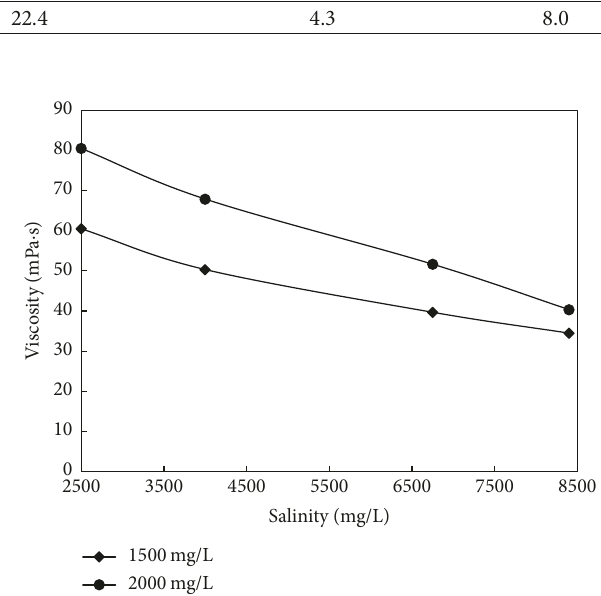
Figure 2: Viscosity of SP solution with different salinity when polymer concentrations are 1500mg/L and 2000